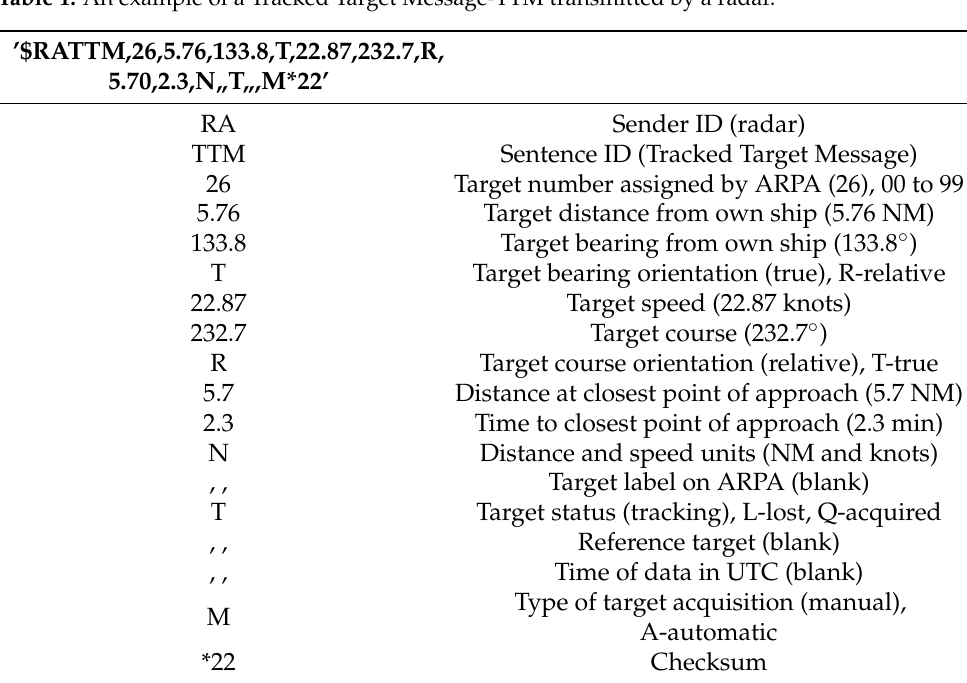
Figure 5. Dynamic trial maneuver in Furuno radar. Table 1. An example of a Tracked Target Message-TTM transmitted by a